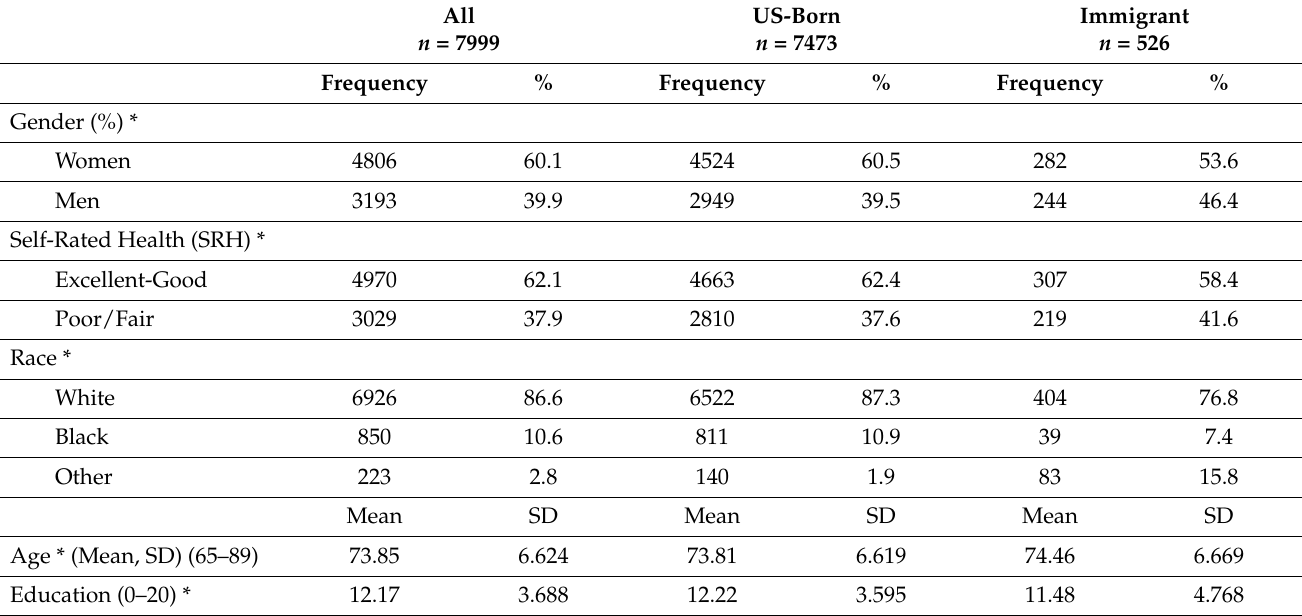
Table 1. Distribution of demographic factors overall and by immigration